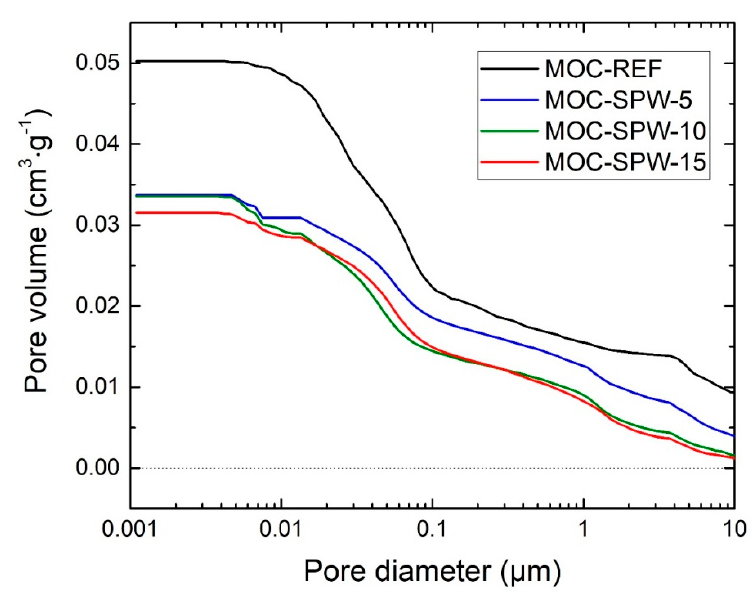
Figure 3. Cumulative pore volume curves of examined composites. Table 6. Parameters of pore volume distribution.